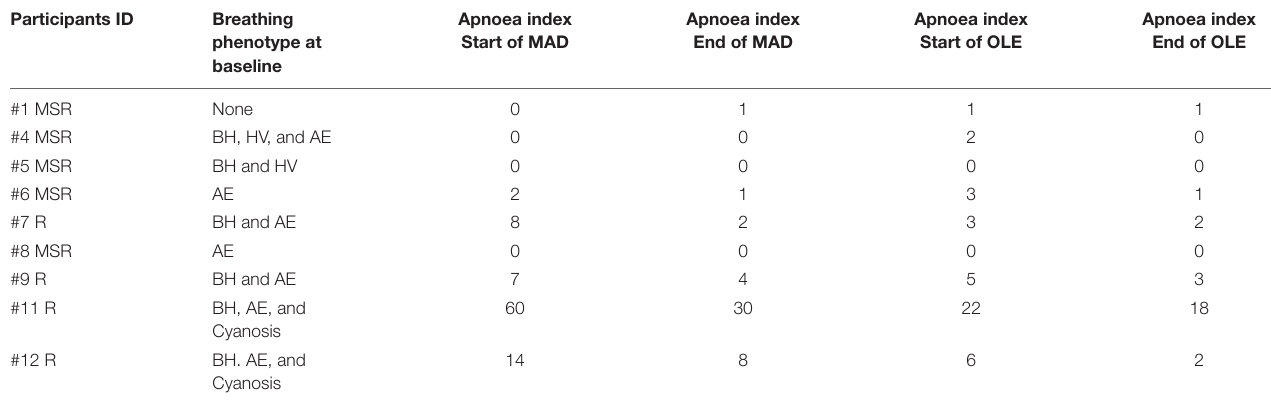
FIGURE 1 | Study design and dosing schedule of phase I mecasermin trial in RTT. All participants ( n = 12) were included in the multiple ascending dose (MAD) period while only those with RTT ( n = 9; n = 7 at T2) and one with MRD progressed onto the open label extension (OLE) component. Participants were administered mecasermin twice daily by subcutaneous injection. Time points when blood sampling was performed are denoted T0 (start of MAD), T1 (end of MAD), T2 (start of OLE), and T3 (end of OLE). Whole blood samples were used for 3 (cid:48) -Digital Gene Expression (3 (cid:48) -DGE) sequencing. TABLE 1 | Apnoea index profiles of participants with classic Rett syndrome